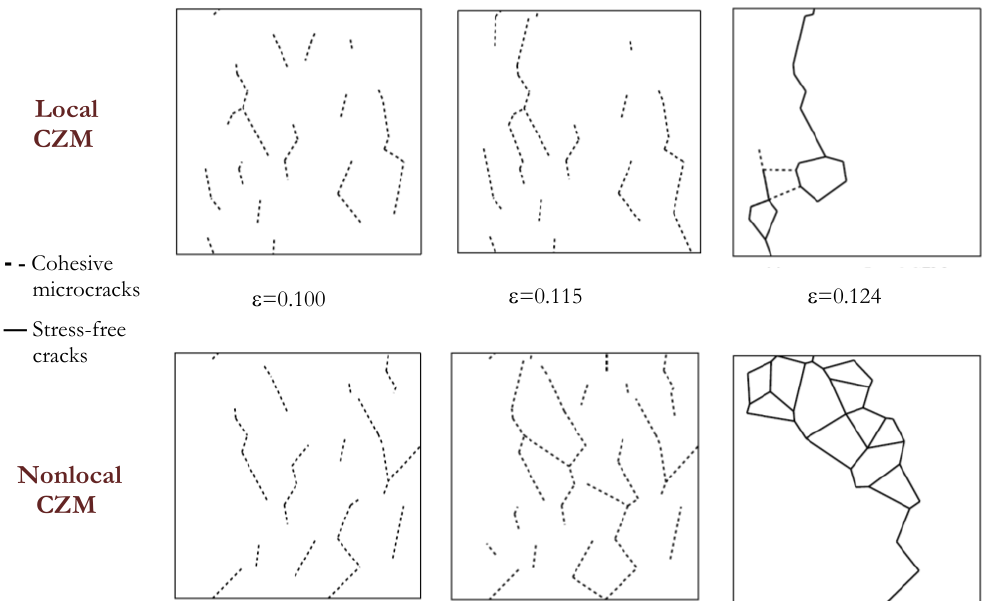
Figure 9: Crack patterns (cohesive microcracks with dashed line and stress-free cracks with solid line) for different strain levels.